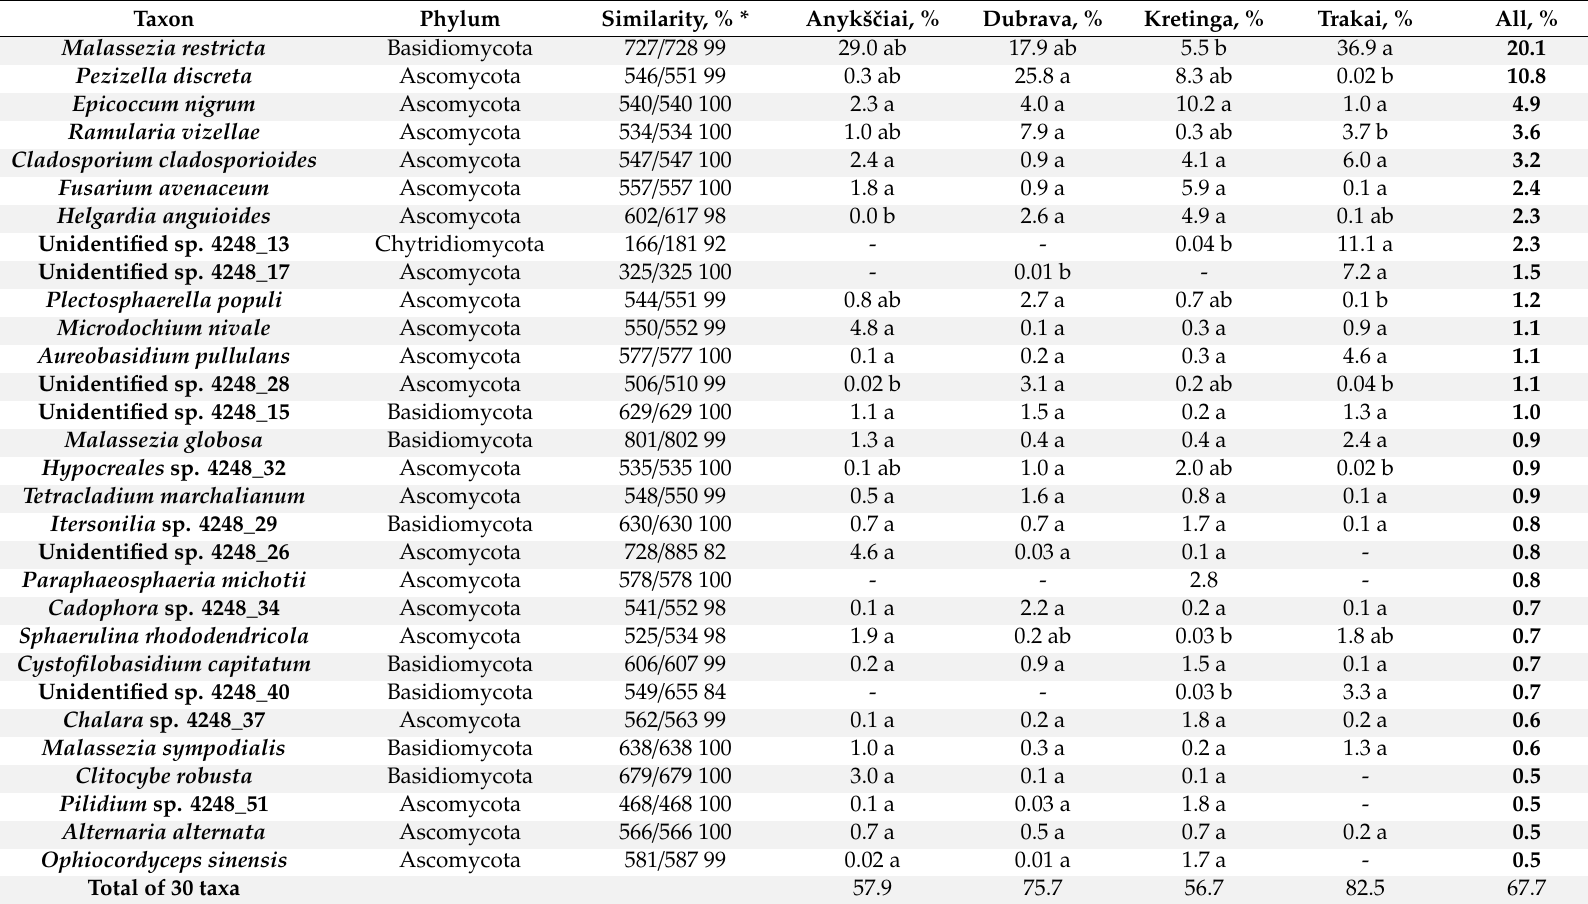
Table 3. Occurrence and relative abundance of the 30 most common fungal taxa (shown as a proportion of all high-quality fungal sequences) from irrigation water filtrate samples in Anykšˇciai, Kretinga, Trakai, and Dubrava forest nurseries. Within each row, values followed by the same letter do not di ff er significantly at p >